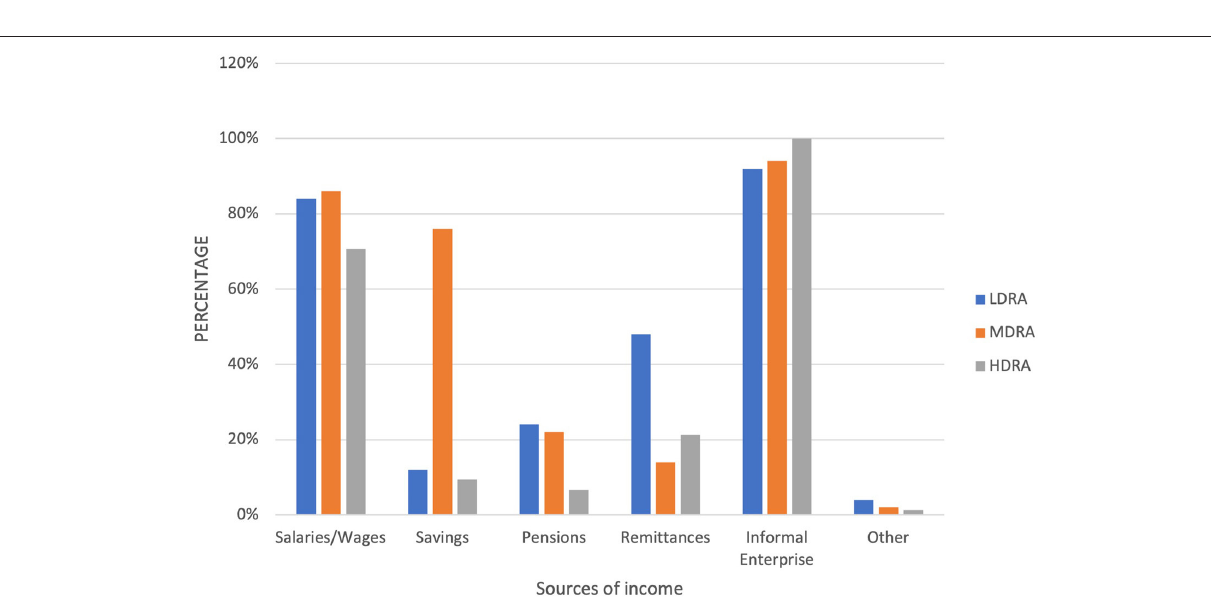
Frontiers in Sustainable Cities |